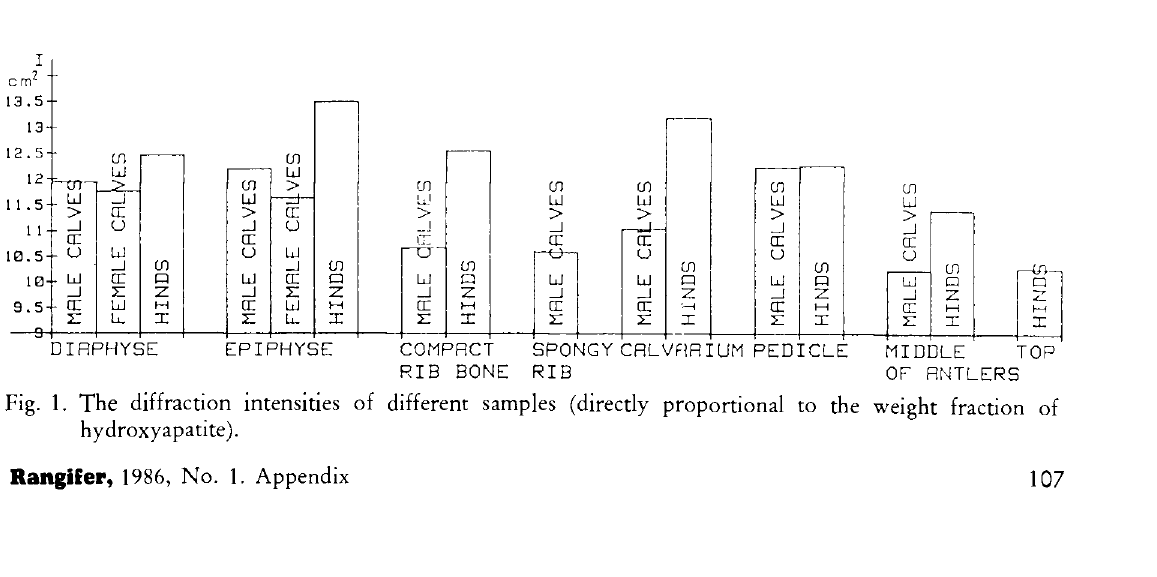
Fig. 1. The diffraction intensities of different samples (directly proportional to the weight fraction of hydroxyapatite). Rangifer, 1986, N o. 1.